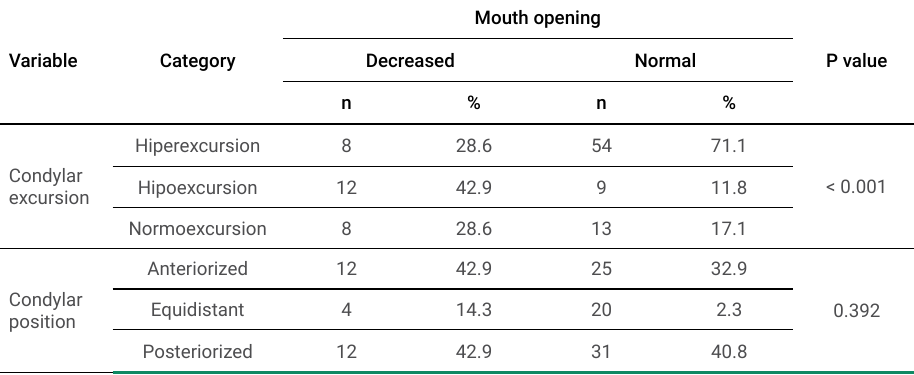
Table 7. Cross tabulation of the condylar excursion estimates, condylar positions, the mouth opening and the significance of the chi-square test